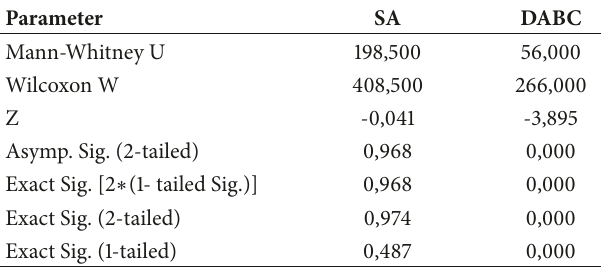
Table 4: Wilcoxon Mann-Whitney U Test.